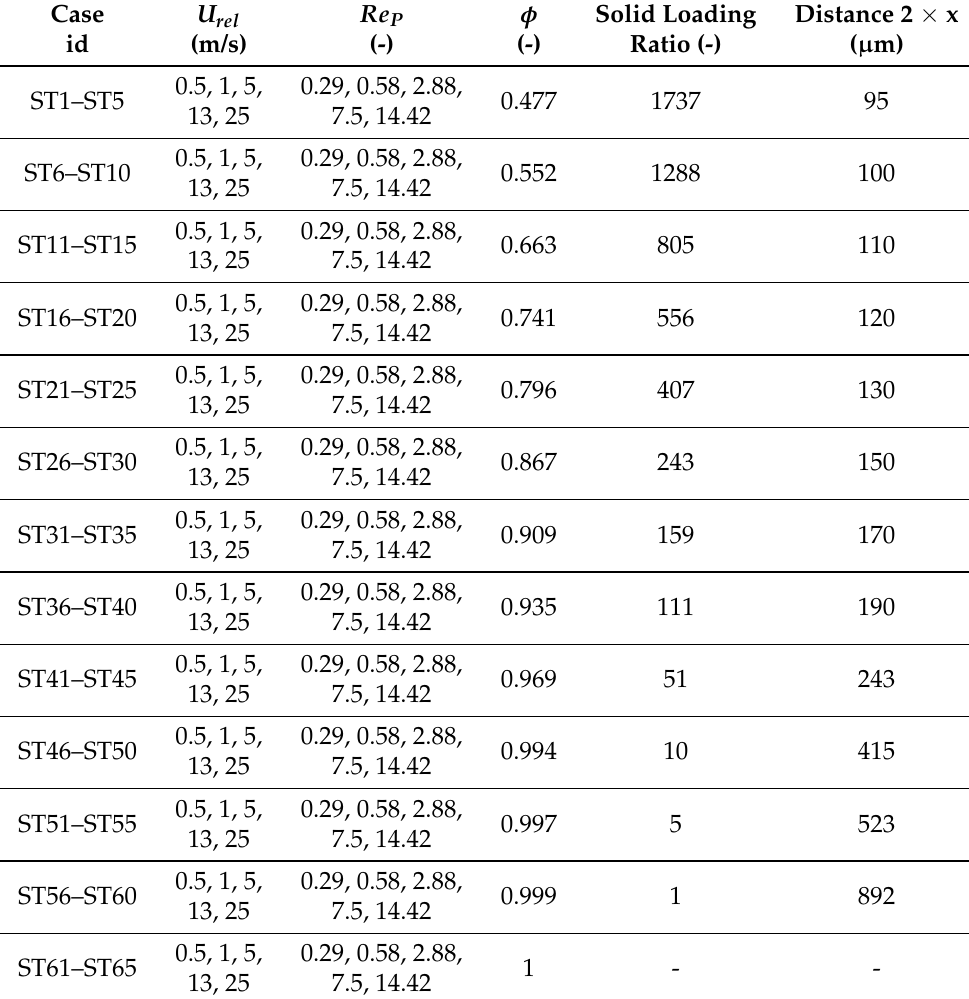
Table 5. Summary of particle cluster